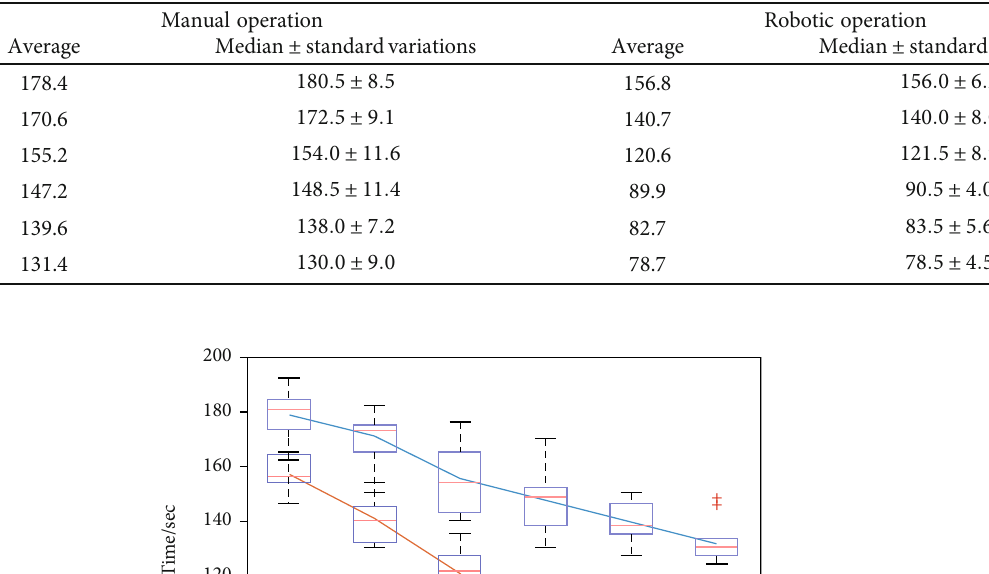
Figure 13: (a) Setup of the phantom experiment; (b) fi eld of view from the fl exible ureteroscope. Table 4: Results of the phantom experiment (unit: sec).